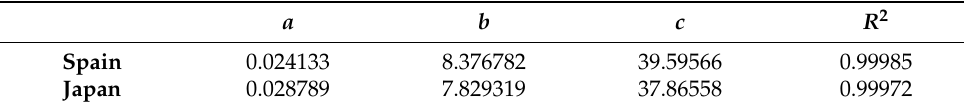
Table 3. Values of the parameters of Formula (4). a b